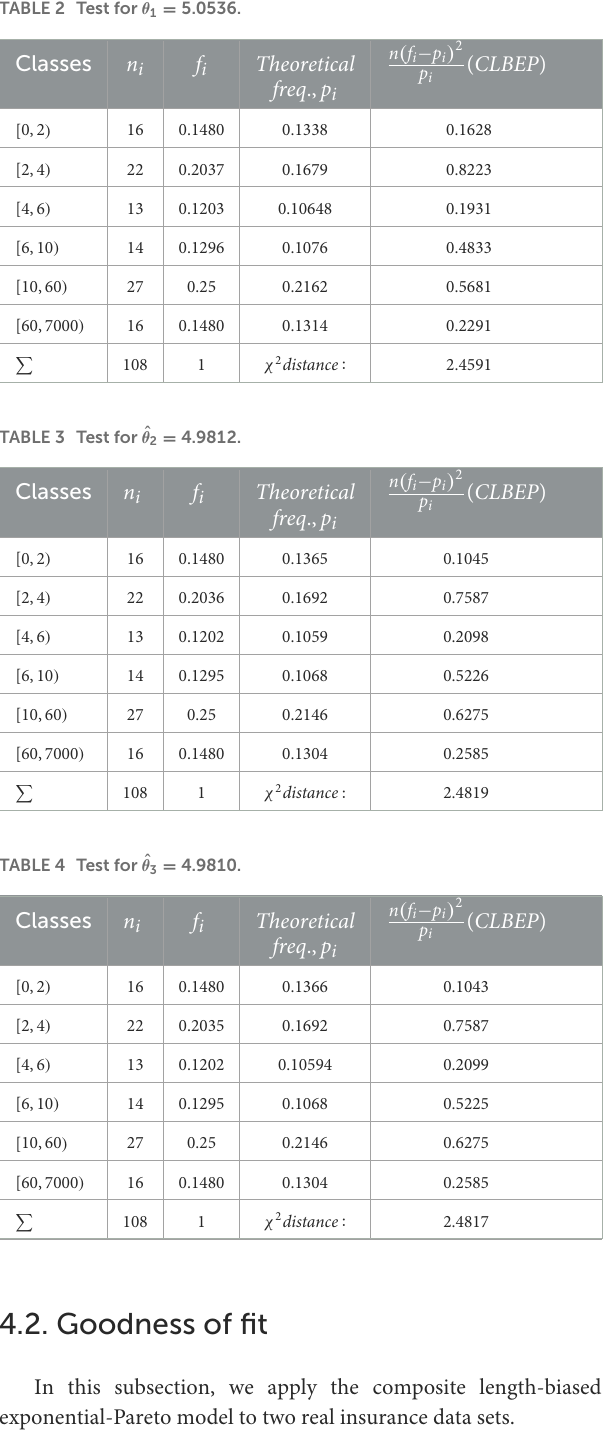
TABLE 2 Test for ˆ θ 1 = 5.0536.